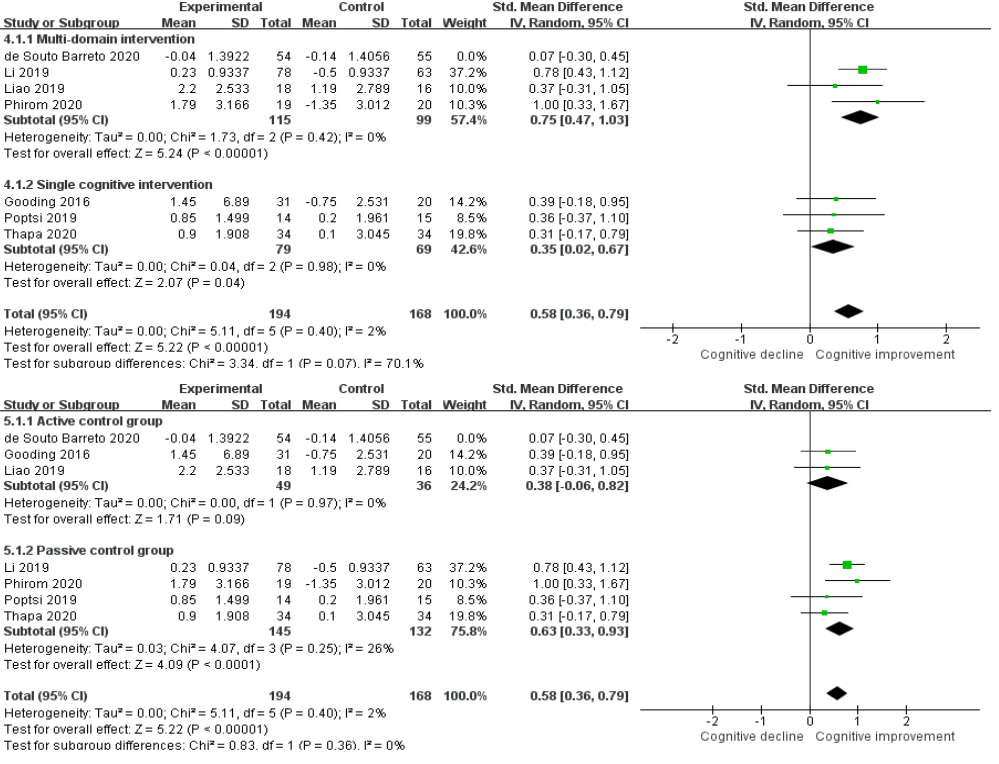
Figure 6. Forest plots of subgroup analysis after excluding heterogeneous